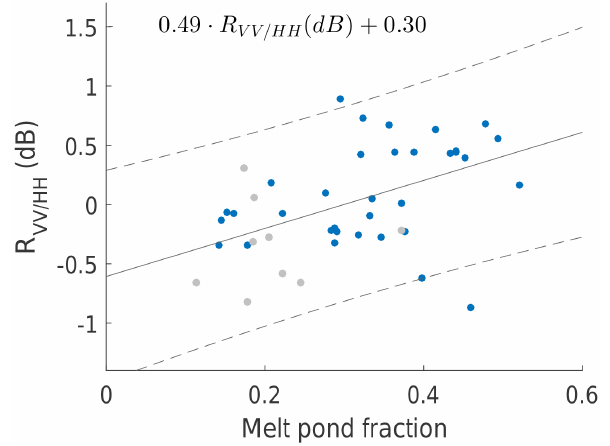
Figure 4. Scatter plot displaying f MP retrieved from the 43 he- licopter images covering the investigated floe in T3, and mean R VV / HH extracted from the corresponding areas. Grey dots repre- sent areas with partly deformed sea ice, while blue dots represent ar- eas of level ice. The trend line represents a robust bisquare weights least-squares linear fit of the data, and the dotted lines represent the 95% confidence interval of the regression. R 2 equals 0.21. fit